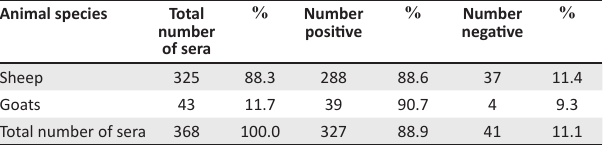
TABLE 2: The overall seroprevalence of peste des petits ruminants virus antibodies, in sheep and goat sera, as demonstrated by Competitive-enzyme linked immunosorbent